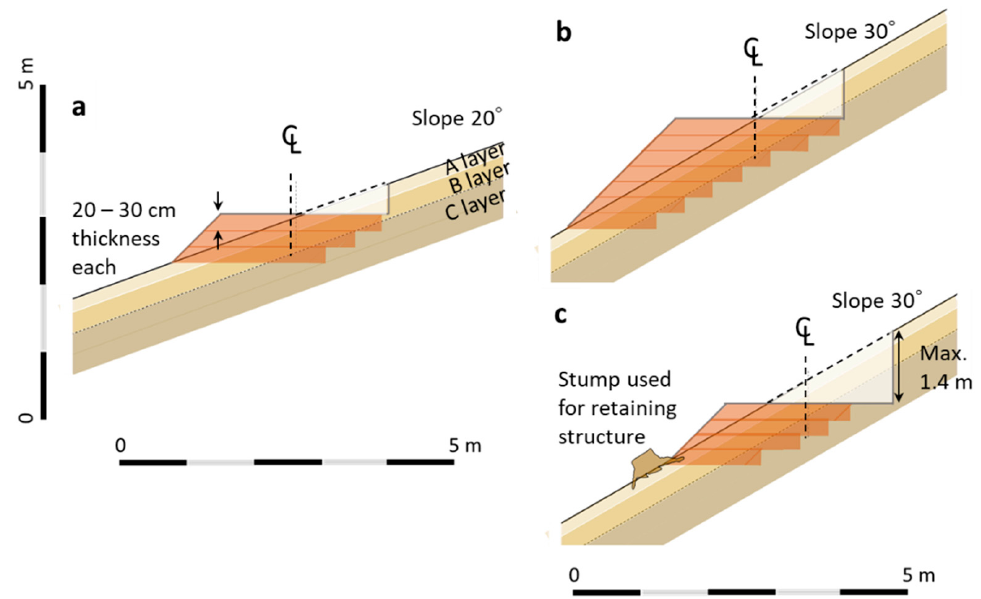
Figure 2. Spur road construction in Kochi University Forest using the Shimanto method. The soil was dug over once with additional depth, and then compacted with layers of 20–30 cm thickness.